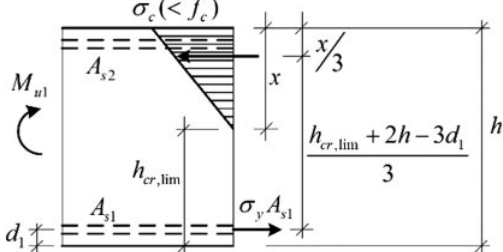
Fig. 3. Design state of stress within the cross section when tensile reinforcement